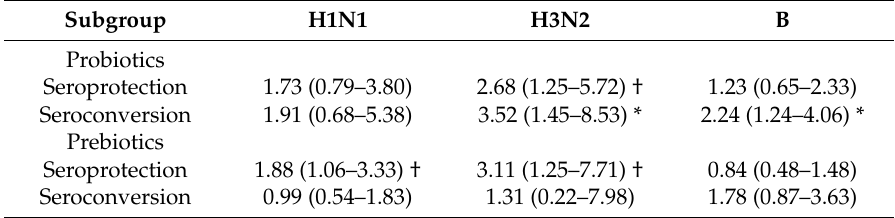
Table 3. Subgroup analysis of odds ratio of seroprotection and seroconversion rate for different influenza vaccine strains based on